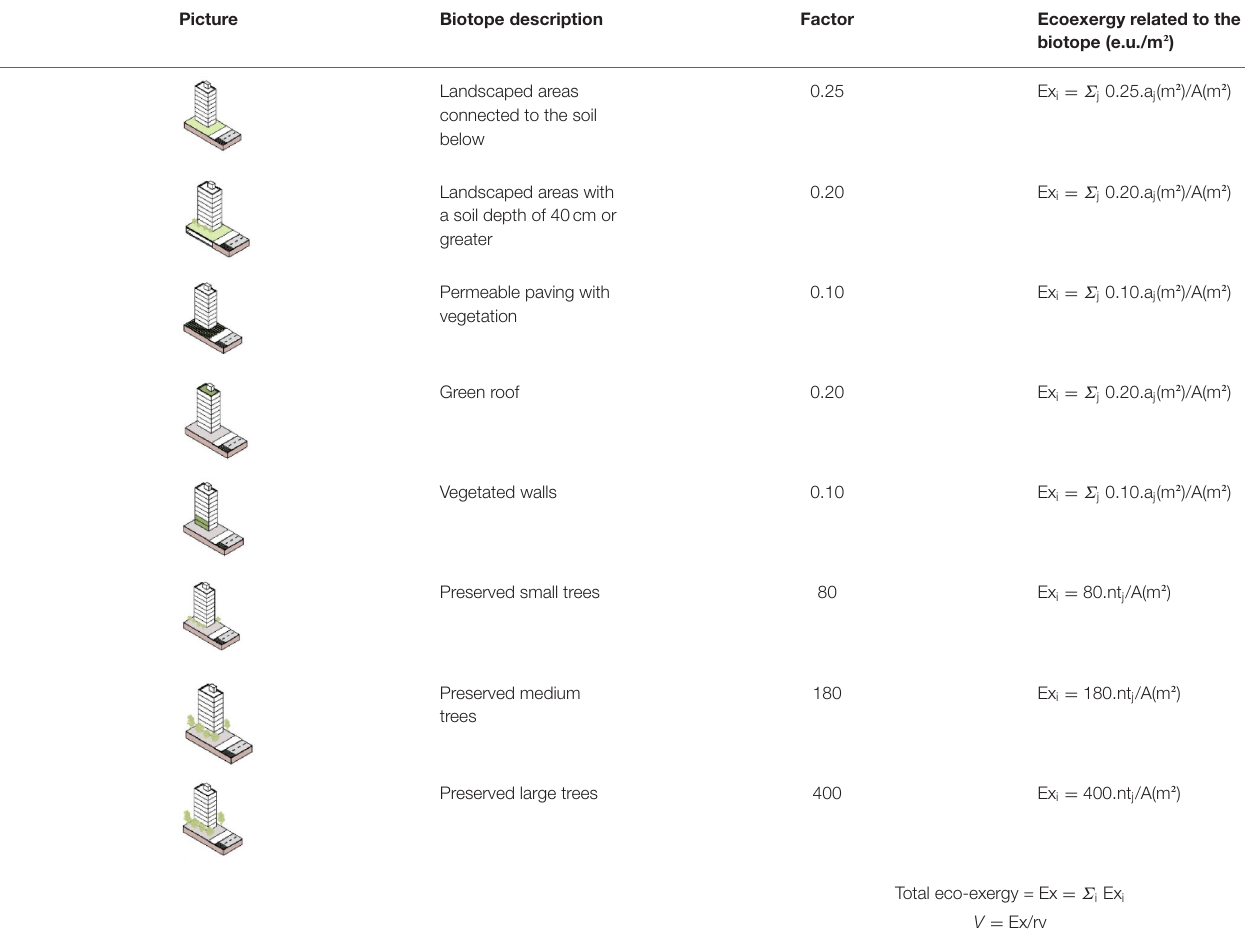
TABLE 2 | Calculation of indicator V.